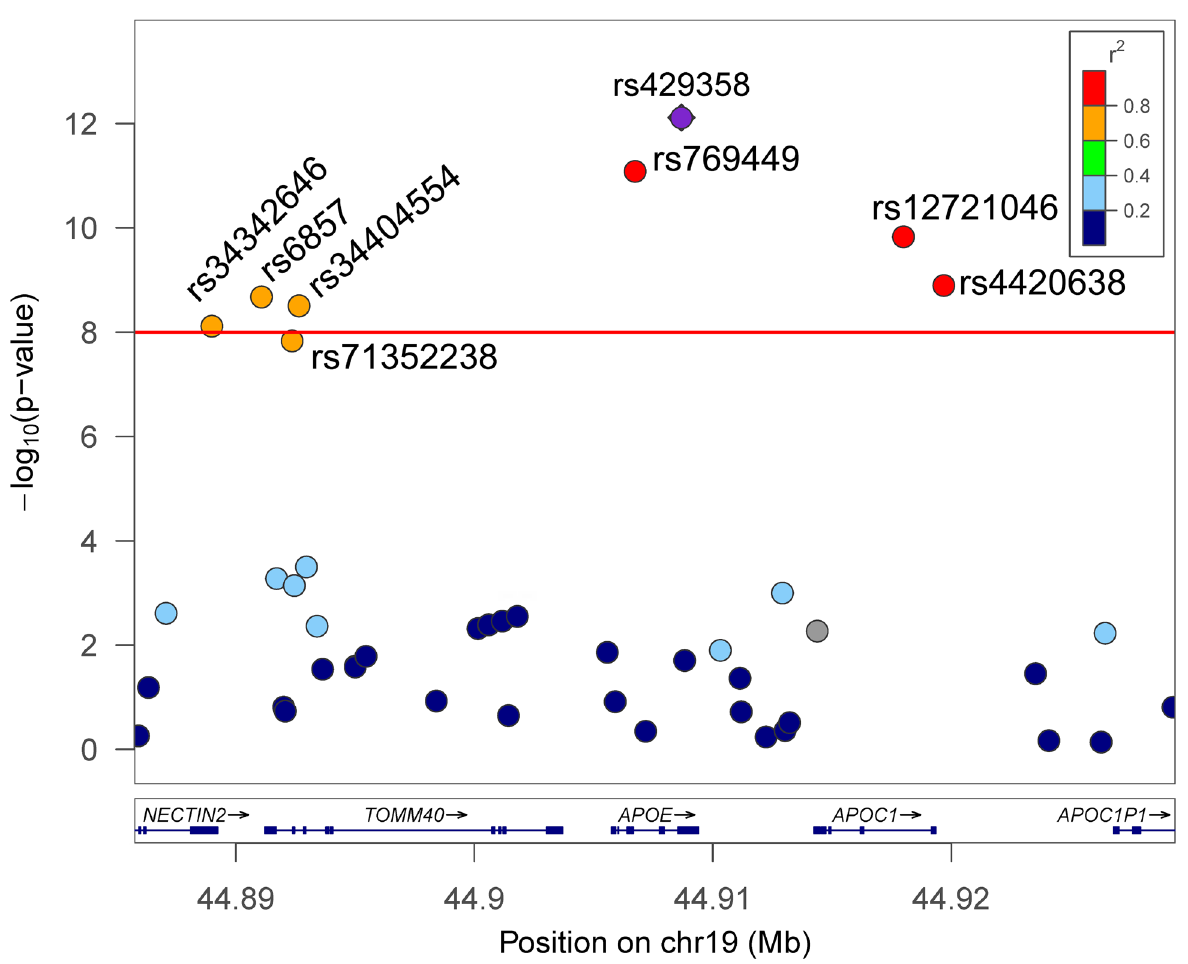
Figure 3 – Locuszoom plot illustrates the linkage disequilibrium and recombination rate between four genes in chromosome 19 in male participants. The genes include APOE , APOC1 , PVRL2 , and TOMM40 . It showed the polymorphism rs429358 was the major variant for low high-density lipoprotein cholesterol in